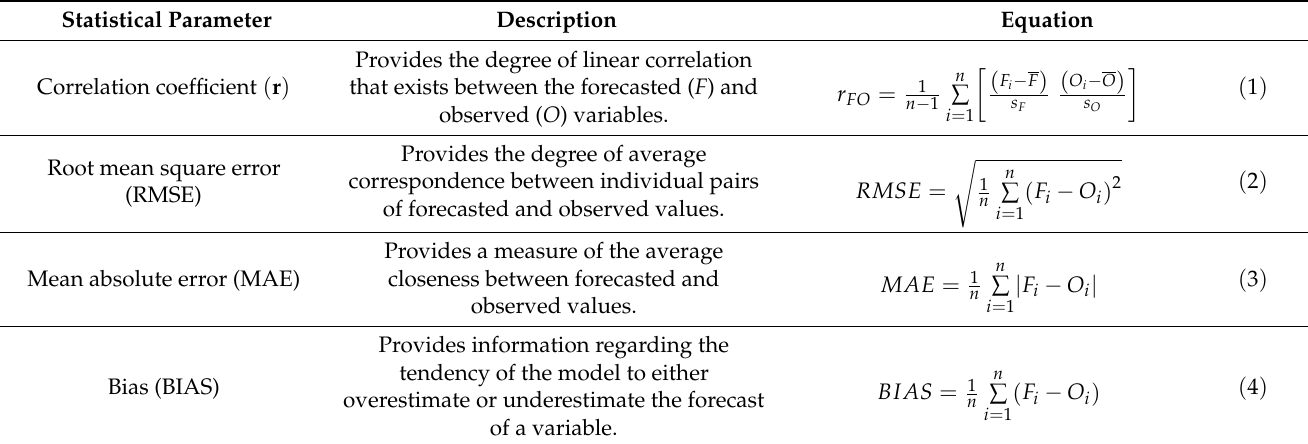
Table 3. Statistical parameters for temperature validation (Jolliffe and Stephenson, [22]; Wilks, [23]; the World Meteorological Organization, [30] and Corrales et al., [3]). The statistic’s name, a short description, and its equation are indicated. The statistics’ letters mean the following: forecasted value ( F ) , observed value ( O ) , forecasted value mean (cid:0) F (cid:1) , observed value mean (cid:0) O (cid:1) , forecasted value standard deviation ( s F ) , observed value standard deviation ( s O ) , pairs of forecast and observations th of n pairs of forecast and observations. ( n ) . F i , O i is the i Description Equation that exists between the forecasted ( F ) and observed ( O )